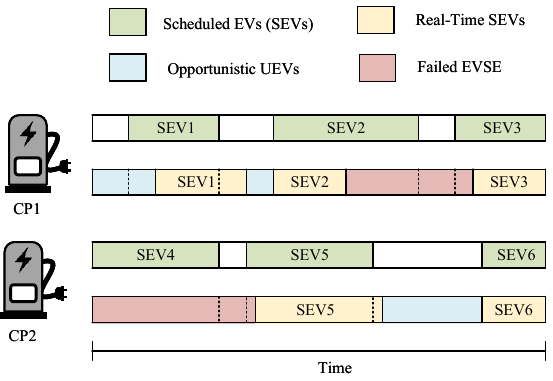
Figure 2. Utilization of charging resources by UEVs